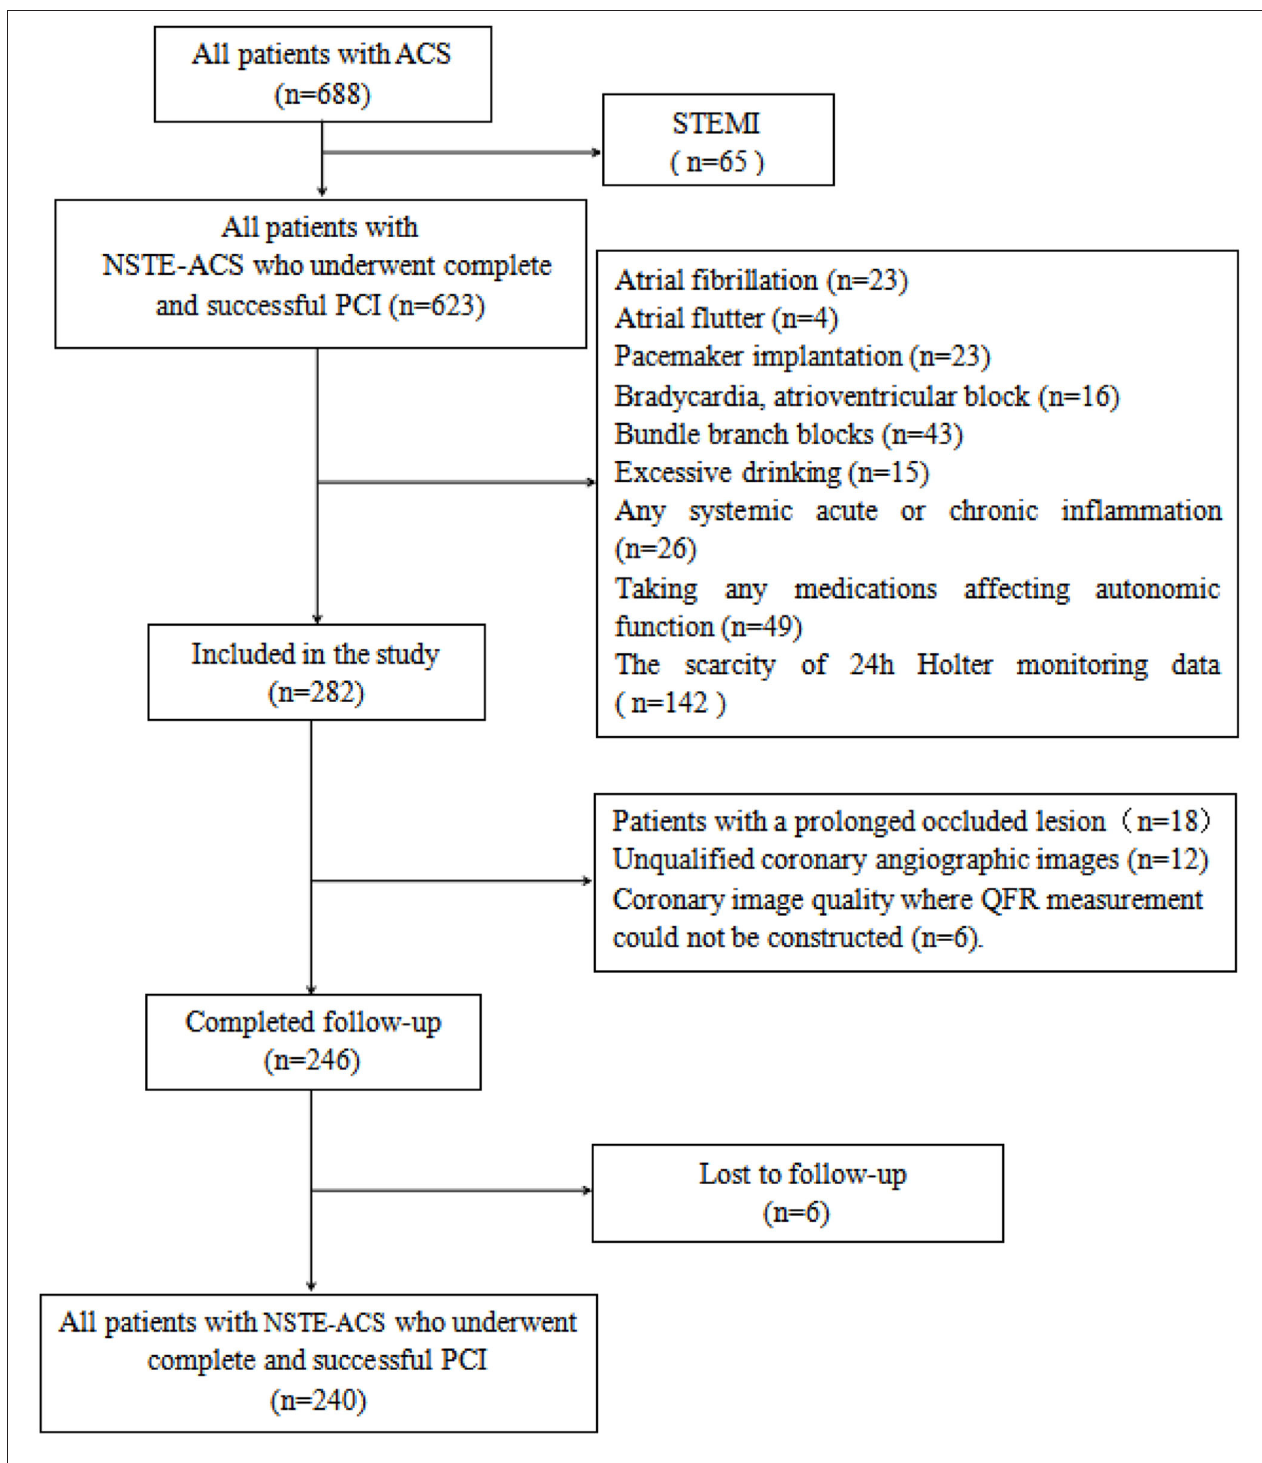
FIGURE 1 | Flowchart of patient